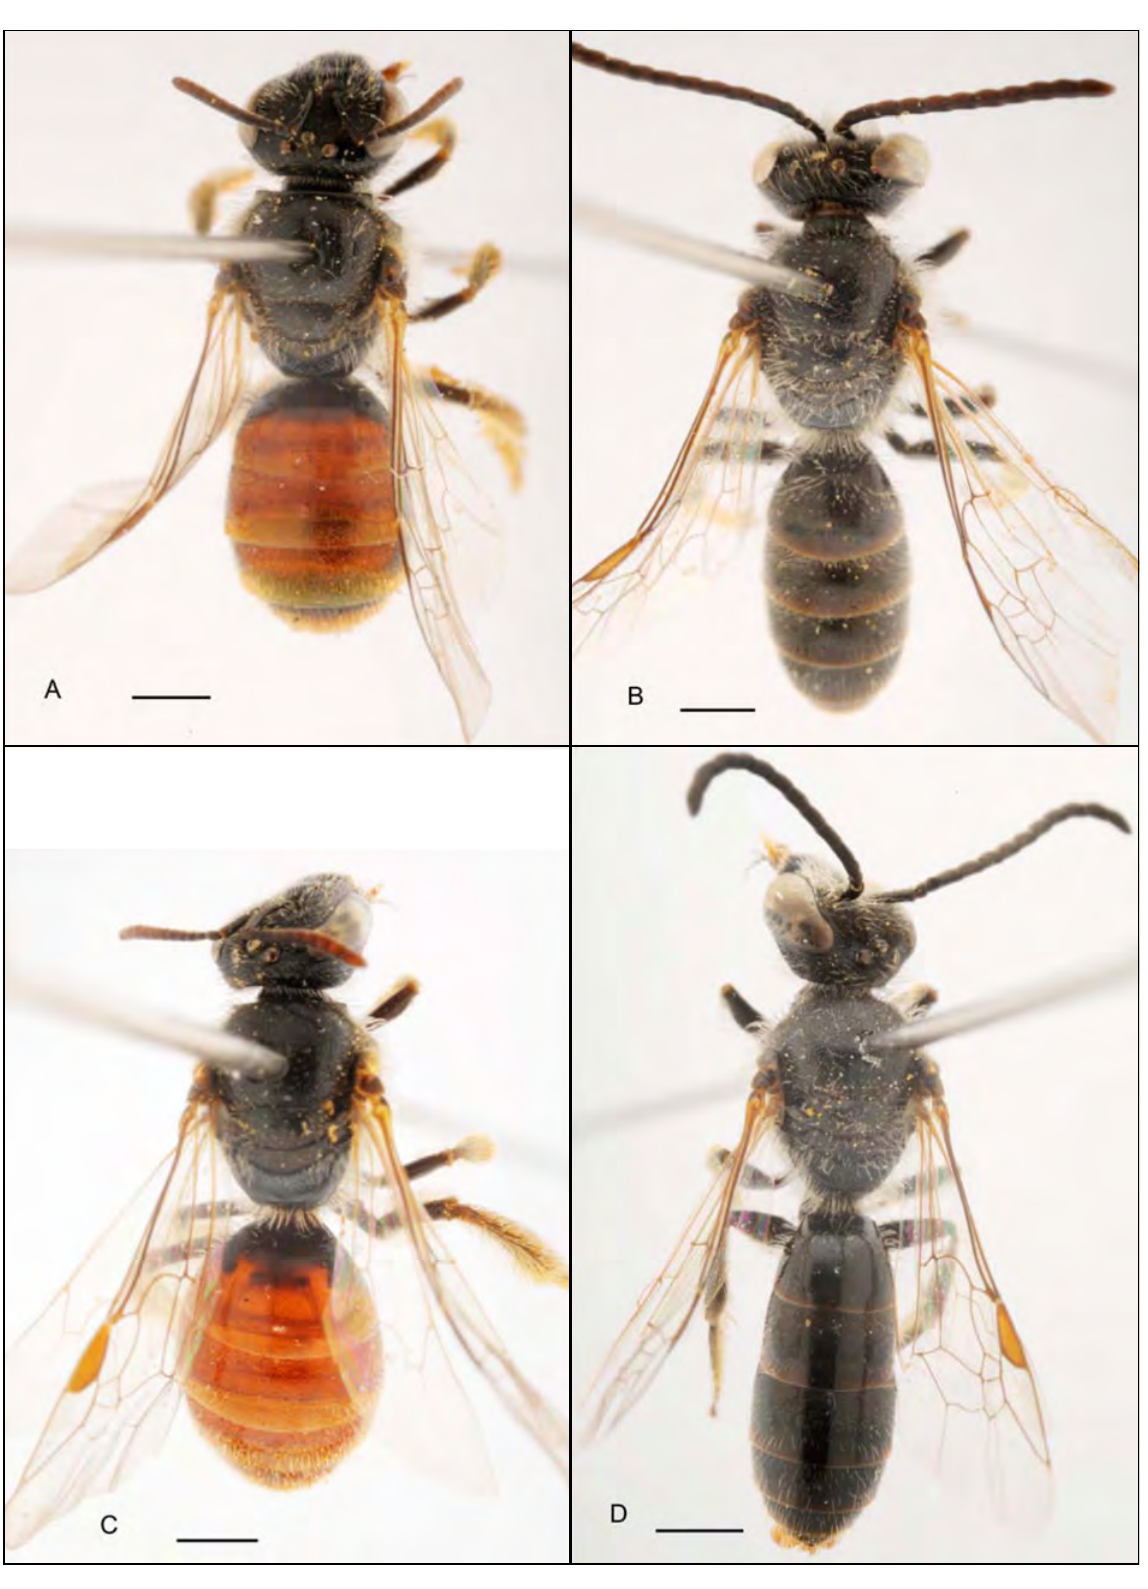
Fig. 10. Dorsal habitus. — A-B . Lasioglossum mosselinum (Cockerell, 1945). A. ♀. B. ♂. — C-D . Lasio- glossum timmermanni sp. nov. C. ♀. D. ♂. Scale line = 1